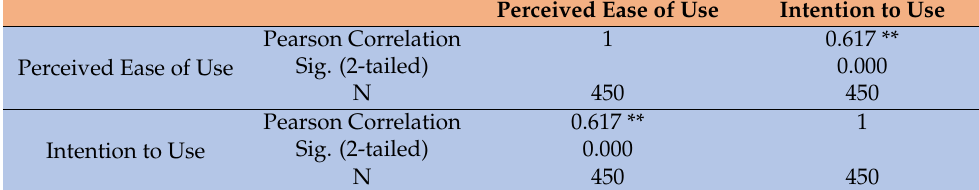
Table 13. Results of the correlation analysis for hypothesis 8 (H8).